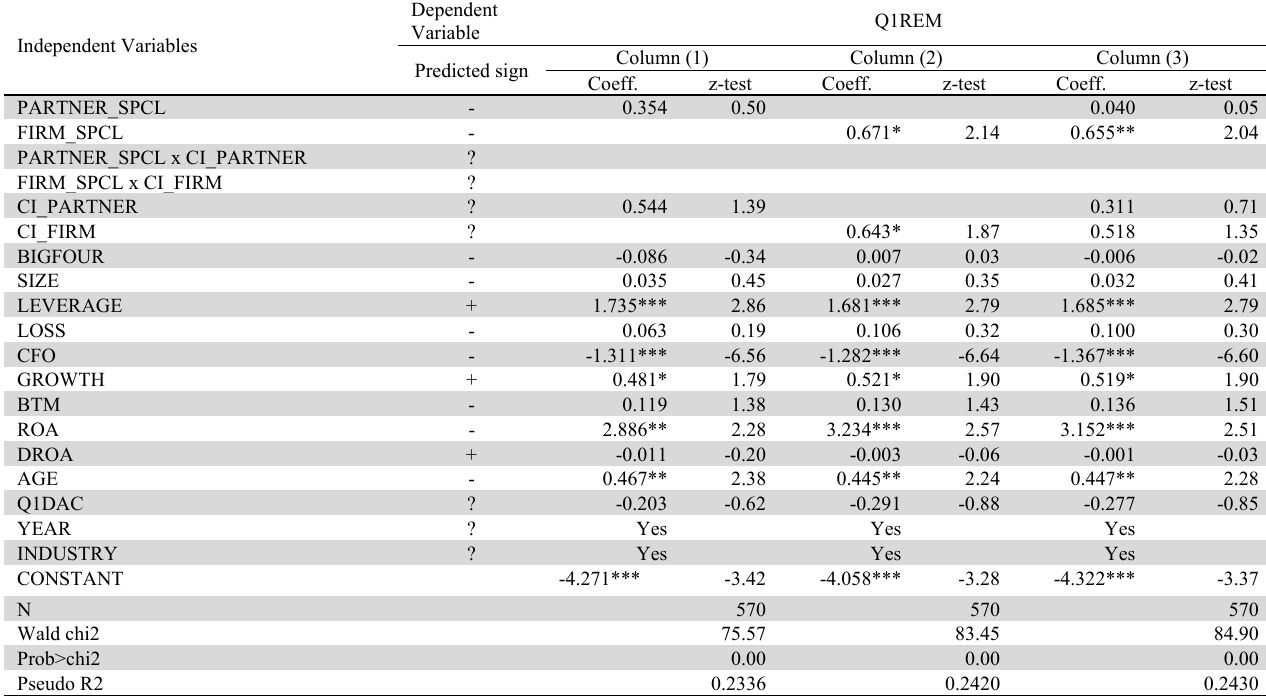
Logistic regression results of H2a and